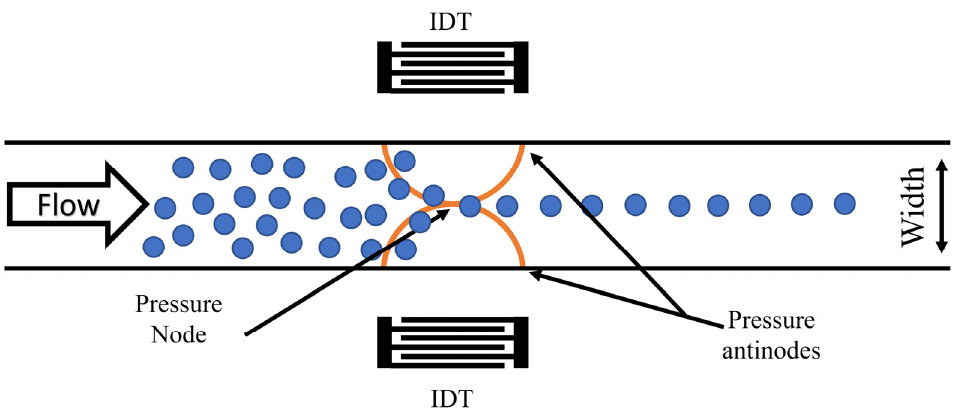
Figure 6. A schematic illustration of the PS particles focusing platform using SSAW. The produced waves consist of two pressure antinodes at the microchannel sidewalls and a single pressure node at the channel’s center.